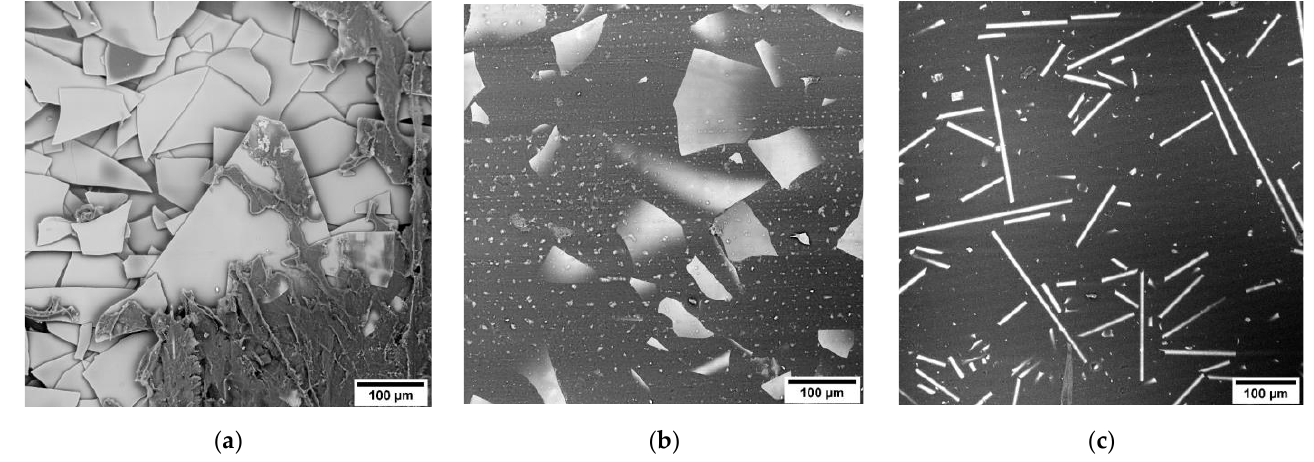
Figure 1. SEM images of the surface of precursor films ( a ); compacted samples with 31 vol.% of GF300 M ( b ) and 16 vol.% of MGF ( c ).